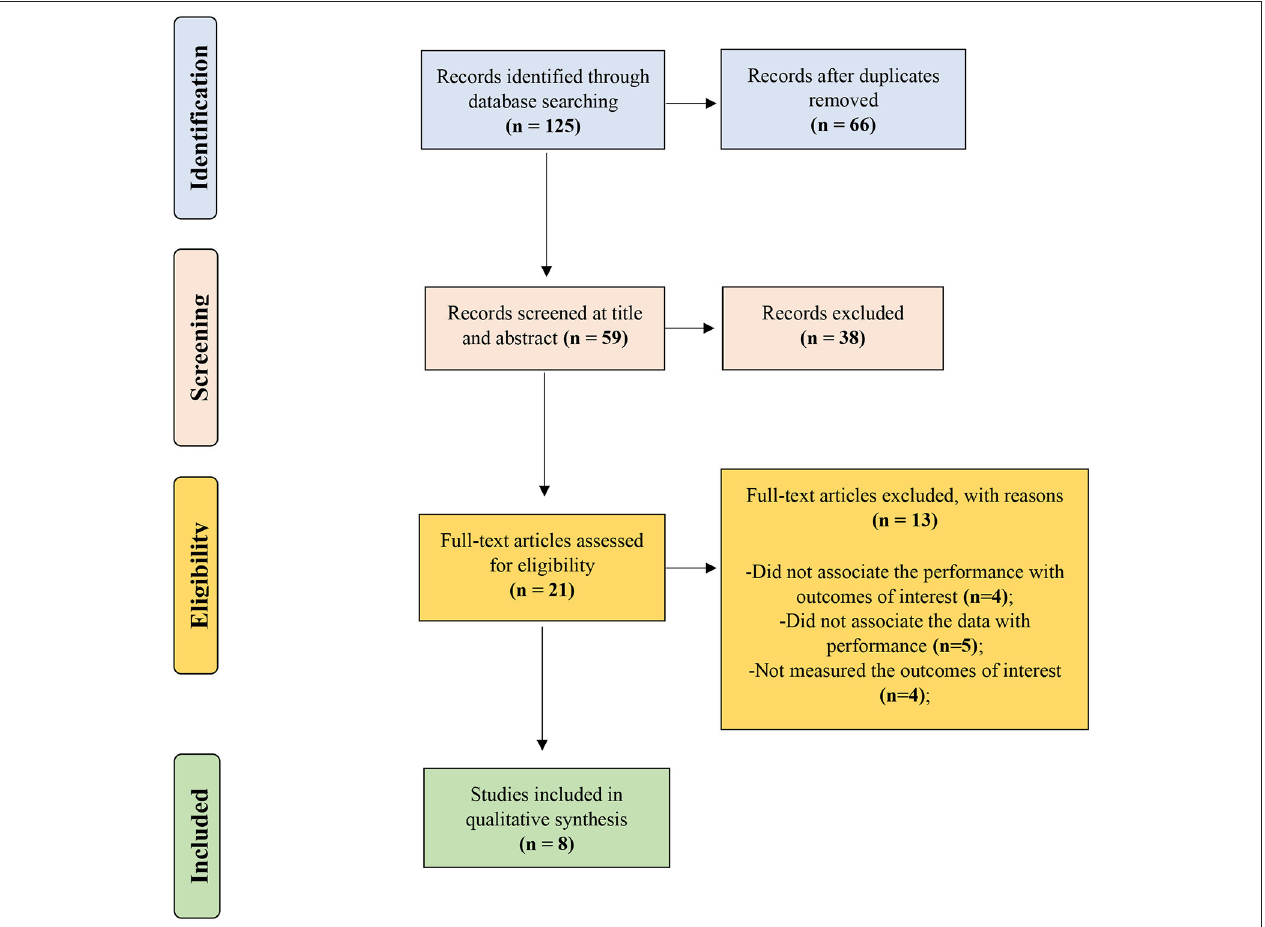
FIGURE 1 | Flow diagram of the Preferred Reporting Items for Systematic Reviews and Meta-Analyses